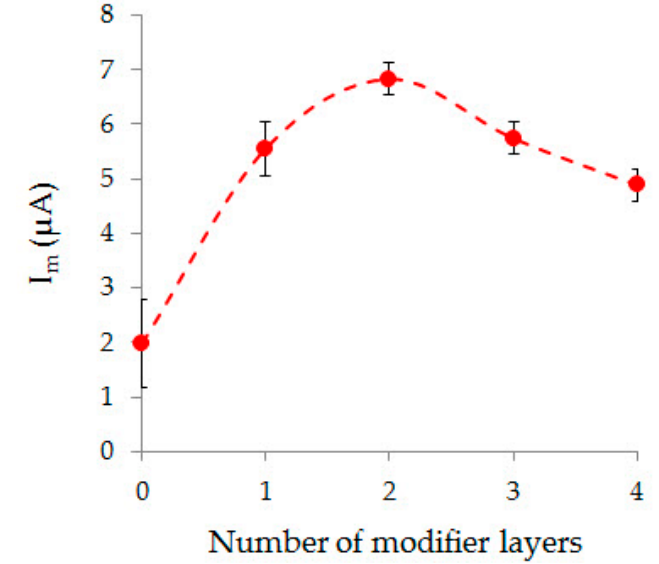
Figure 2. Effect of the modifier layers number on the oxidation current of 0.1 mM AA on Au-gr/CVE in the PBS pH 7.